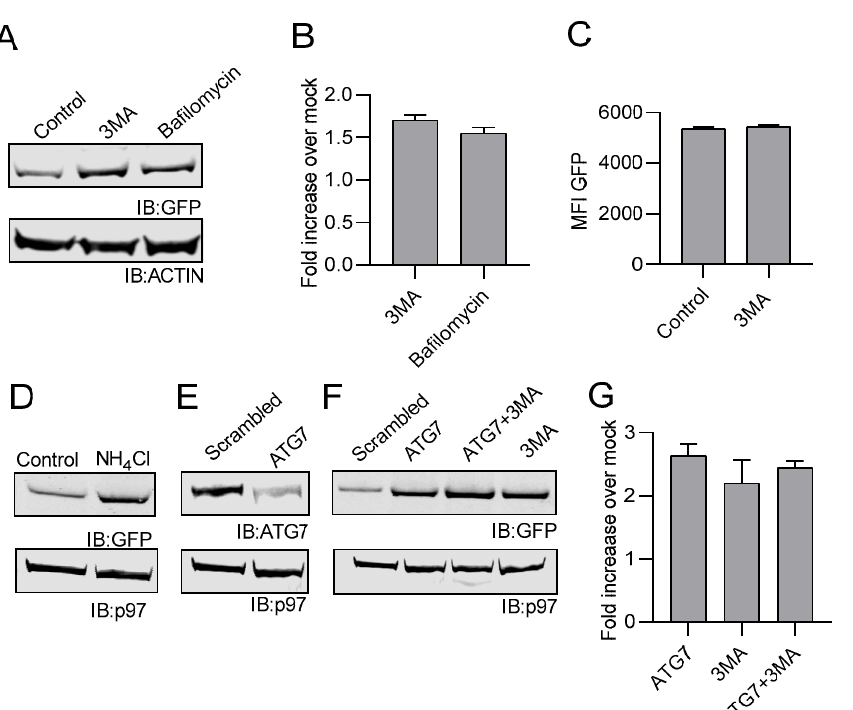
Figure 4. Non-cleavable NEDD8-GFP undergoes autophagosomal degradation. ( A ) Western blot analysis of EL4/NC NEDD8-GFP cells following a 5-h treatment with autophagy inhibitors 3-MA or bafilomcyin. Cell lysates of NC EL4/NEDD8-GFP cells and NC EL4/NEDD8-GFP treated with inhibitors were made and analyzed by Western blot using mouse monoclonal antibodies against GFP and actin with appropriate secondary antibodies. ( B ) The average fold increase in GFP following autophagy inhibition was determined by Western blot analysis is reported for three independent experiments. ( C ) Flow cytometric analysis for GFP fluorescence of cells after autophagosomal inhibition are compared with mock-treated cells. ( D ) Western blot analysis of EL4/NC NEDD8-GFP cells after overnight treatment with 5 mM NH4Cl treatment. ( E ) Western blot analysis of EL4/NC NEDD8-GFP cells transfected with either scrambled siRNA oligomers or siRNA targeting ATG7. Cell lysates were probed for either ATG7 (top panel) or p97 as a loading control (bottom panel). ( F ) EL4/NC NEDD8-GFP cells were transfected with scrambled or ATG7-targeting siRNAs and cultured with or without 3-MA. Cell lysates were examined by Western blot analysis for GFP. ( G ) GFP signal obtained by Western blot was quantified in three independent experiments. The increase of NC/NEDD8-GFP for each treatment is shown as the fold-increase increases over mock-treated control. Error bars represent the standard error. All Western blot images were cropped to show relevant bands.